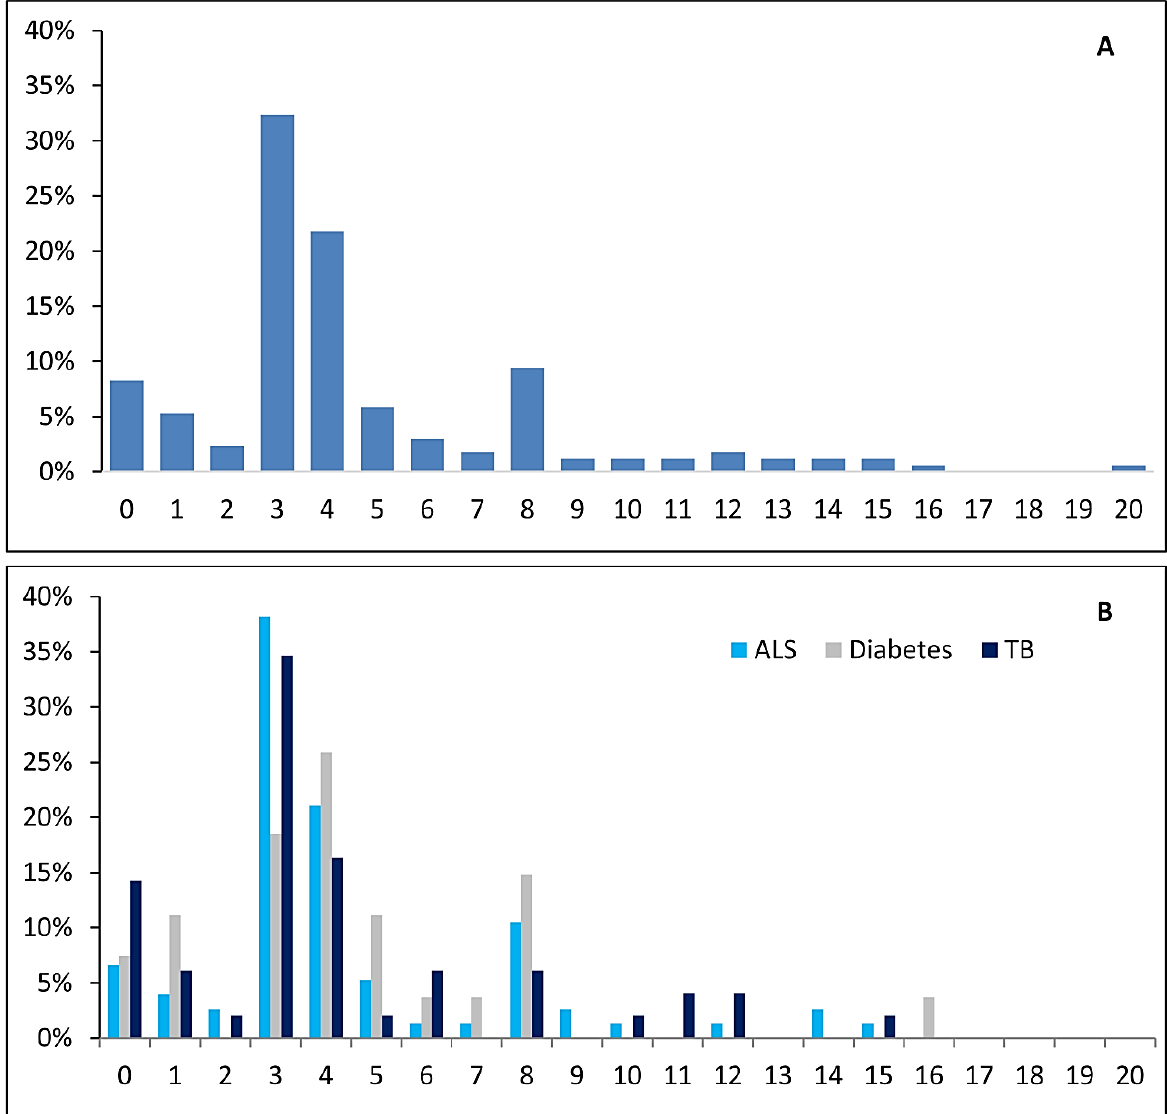
Figure 3. EXEMPLAR score distribution for the whole sample (Figure 3A; N = 170) and by field of research [Figure 3B, with 18 journals publishing studies in more than one field excluded; n(ALS) = 76; n(T1D) = 27; n(TB) = 49)]. The median score for the whole sample (N = 170) was 4 points, whereas the mean scores for ALS, T1D and TB were, respectively 4.45 (SD = 3.15), 4.52 (SD = 3.286) and 4.20 (SD =